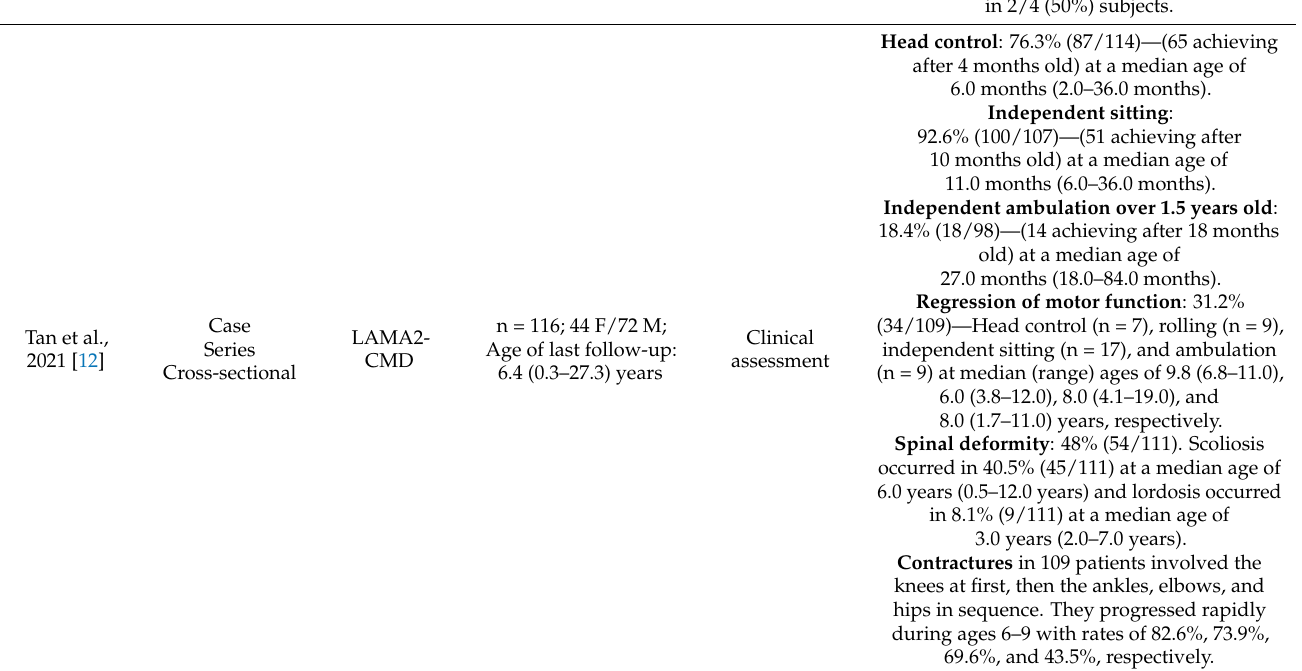
Scoliosis surgery: 0. Contractures —No subjects had right elbow contractures >30 ◦